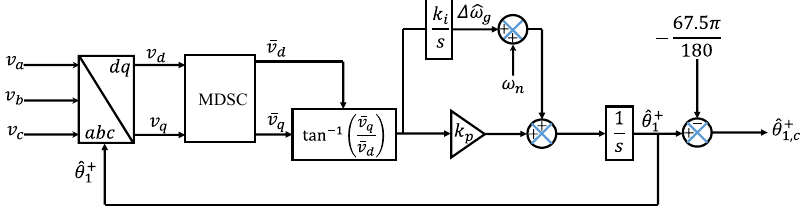
Energies 2023 , 16 , x FOR PEER REVIEW Figure 2. Time-domain implementation of the MDSC operator. Figure 2. Time-domain implementation of the MDSC operator.